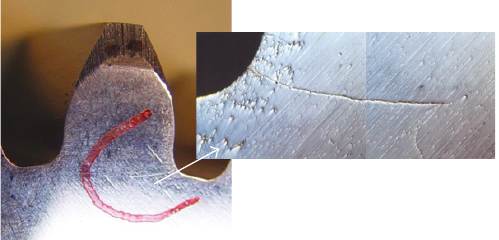
Figure 1: Test plant.